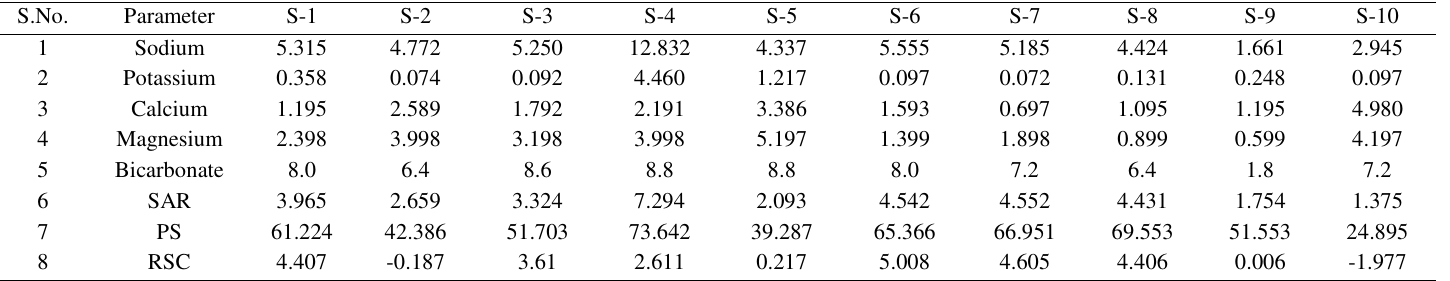
Table-3. Physico-chemical analysis report of Potable waters in MAY-2004